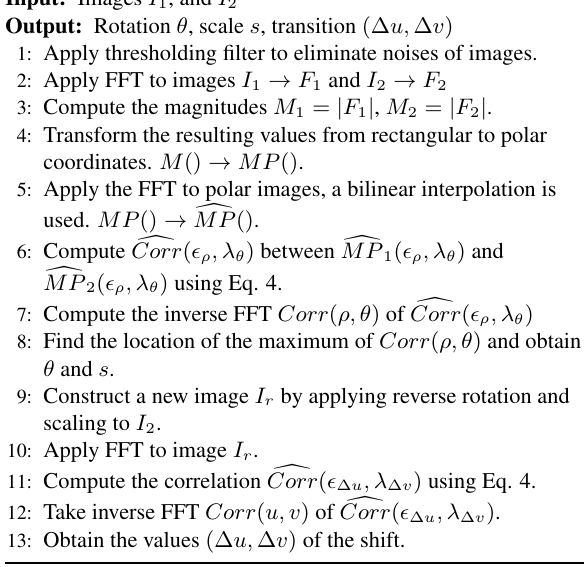
Algorithm 1: Steps of the FMT algorithm for the estimation of transformation